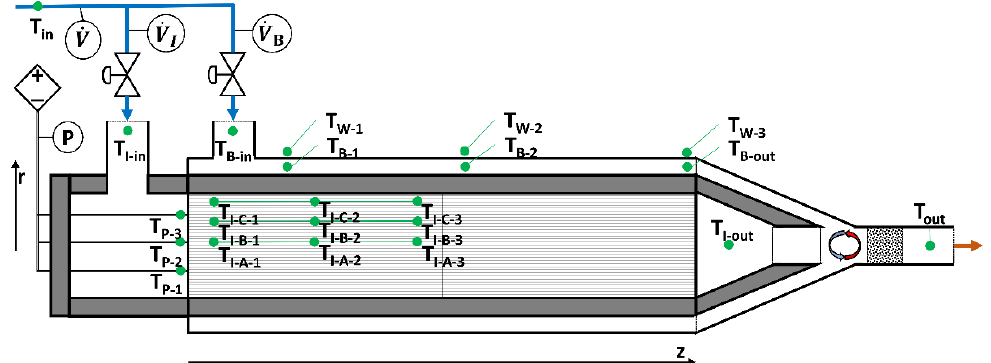
Figure 4. Central measuring